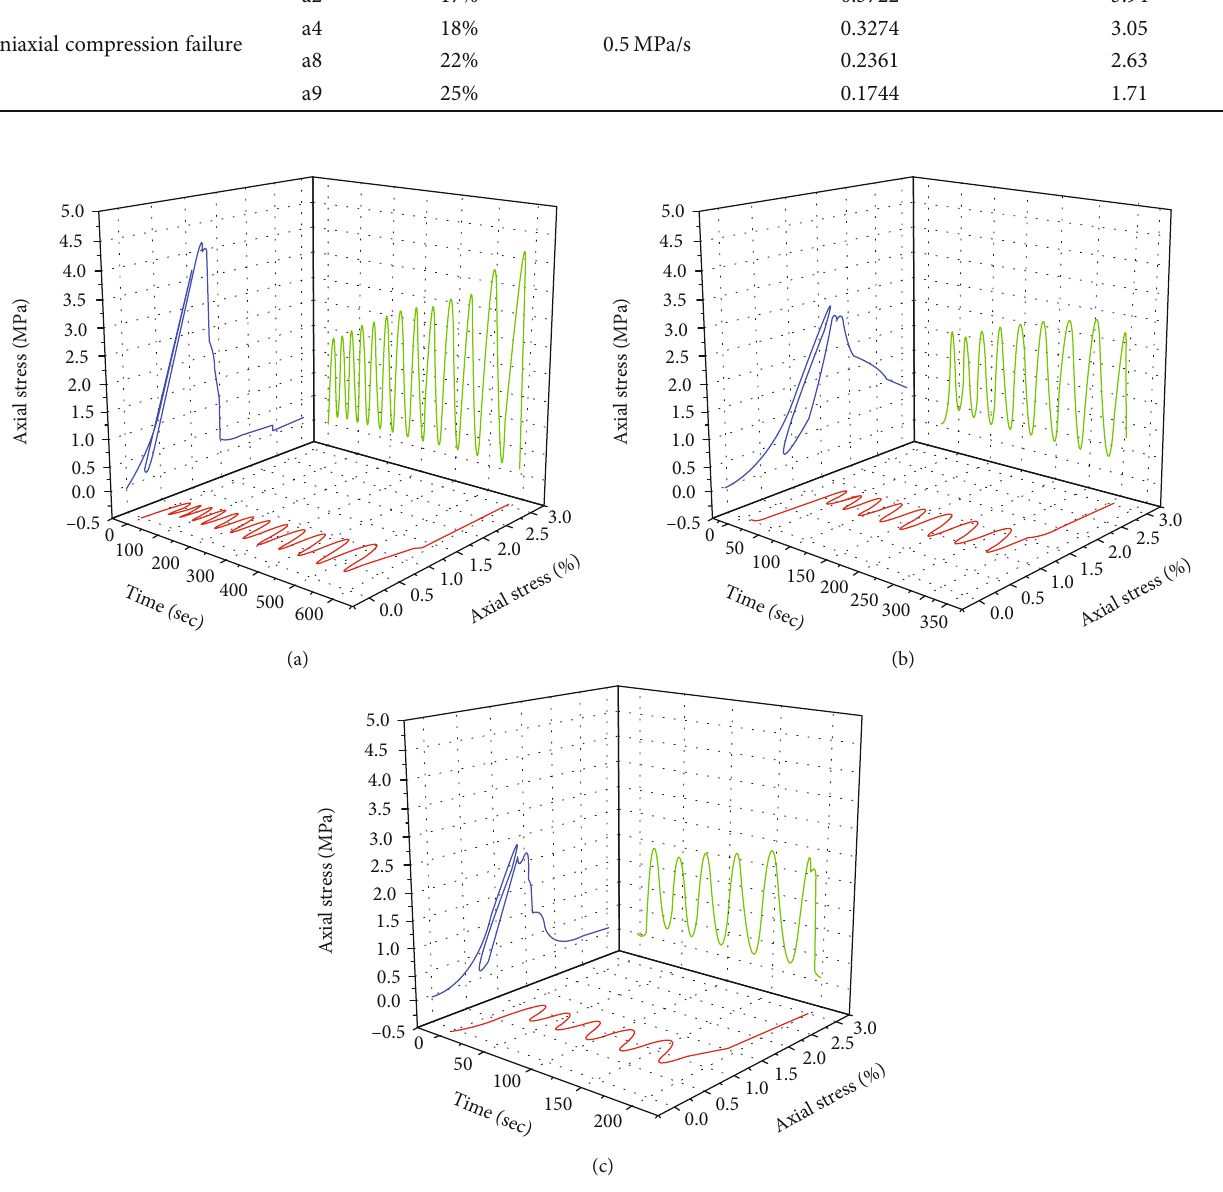
Figure 6: Cyclic loading/unloading curves of coal samples with di ff erent moisture contents ((a) 18%; (b) 21%; (c) 25%). Table 3: Calculation results of cyclic loading energy of coal